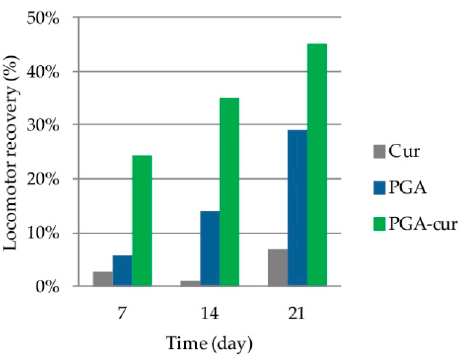
Figure 4. The effect of palmitoyl-glucosamine (PGA) and curcumin (Cur) given individually or in a co-micronized formulation (PGA-Cur) on locomotor recovery.